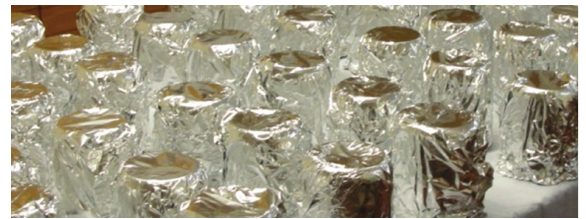
FIGURE 2: Example for placement of